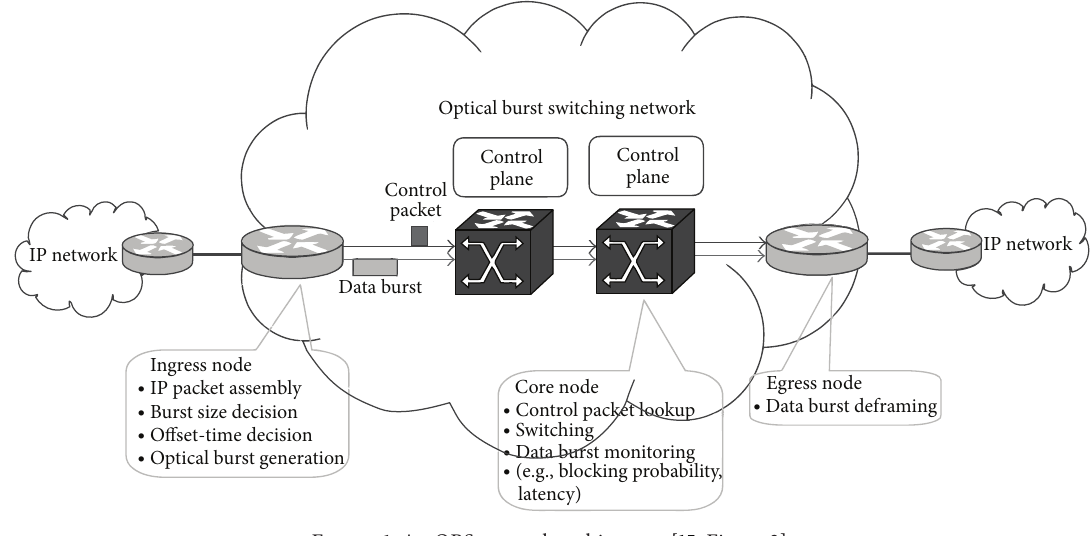
Figure 1: An OBS network architecture [15, Figure 2].